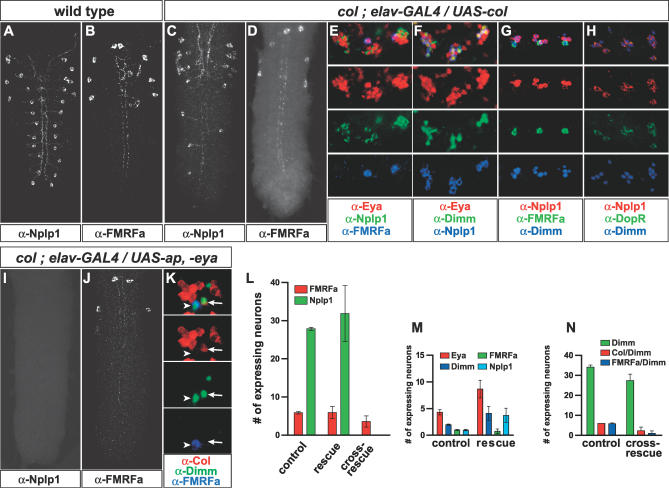

col Rescues Both Tv and Tvb Cell Fate in col Mutants, whereas ap and eya Only Rescue Tv Cell Fate(A and B) Wild-type expression of Nplp1 and FMRFa. (C–H) col rescue of col mutants, in 18-h AEL VNCs.(C and D) col expression in all neurons efficiently rescues back both Nplp1 and FMRFa expression in col mutants.(E–H) Similar to the misexpression results (Figure 5), col rescue results in generation of extra “Ap cluster” neurons, as evident from the expression of Eya, Dimm, Nplp1, and DopR, whereas there is no evidence of ectopic FMRFa expression (lateral view of three thoracic VNC hemisegments; anterior is to the left).(I–K) “Cross-rescue” of col with ap and eya leads to a significant rescue of FMRFa (p < 0.01, n = 35 VNCs), but no rescue of Nplp1. (K) “Cross-rescue” does lead to a partial rescue of Dimm expression in cells expressing Col (a putative “Tvb” cell; arrow), but this cell is never able to activate Nplp1. (The arrowhead points to the FMRFa-expressing Tv cell.) Col can be visualized because the col3 allele is not a protein null.(L–N) Quantification of observed phenotypes (n > 16 VNCs for [L], n > 41 hemisegments for [M], and n > 9 hemisegments for [N]). (L) Expressing neurons per VNC. (M) Expressing neurons per Ap cluster. (N) Expressing neurons for the three thoracic segments combined.Genotypes: (A and B) wild type, (C–H) col1/col3; elav-GAL4/UAS-col, and (I–K) col1/col3; elav-GAL4/UAS-ap, UAS-eya. (L–N) Controls are w1118.